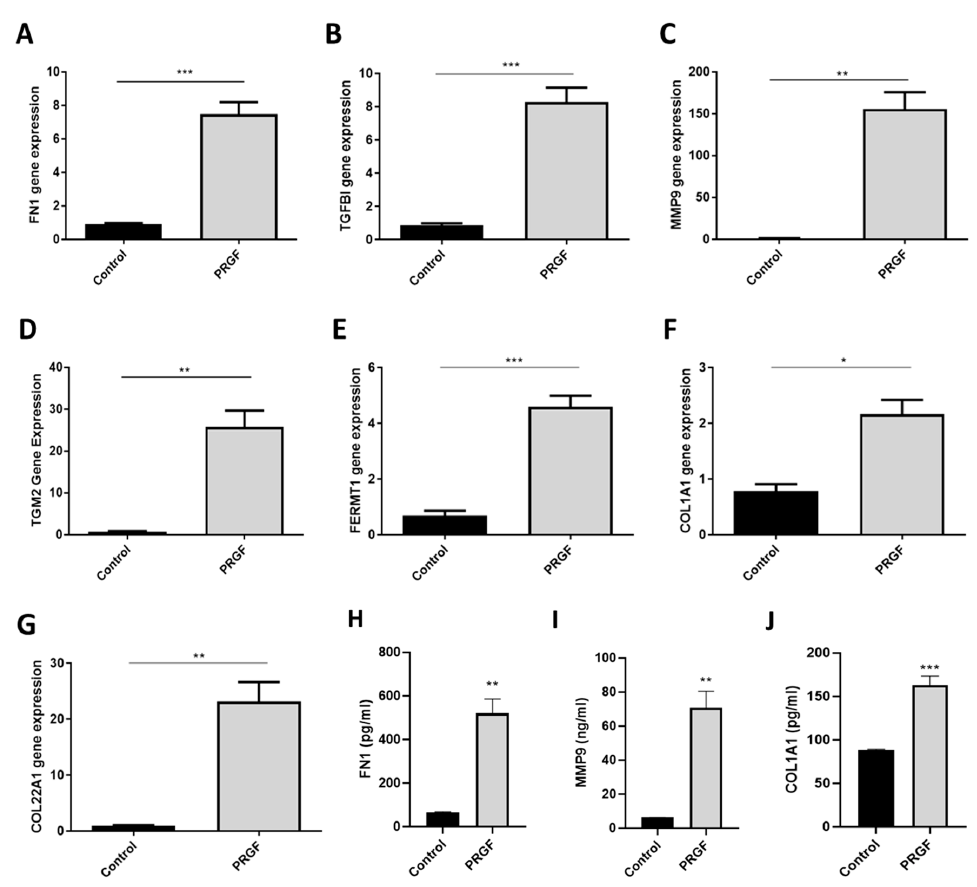
Figure2. PRGFinducesgeneexpressionofvariousextracellularmatrix(ECM)-relatedproteinsinhuman Figure 2. PRGF induces gene expression of various extracellular matrix (ECM)-related proteins in human keratinocytes. Human primary keratinocytes were stimulated for 20 h with PRGF keratinocytes. Human primary keratinocytes were stimulated for 20 h with PRGF preparations derived preparations derived from 10 different donors. Relative gene expression of FN1, TGFBI, MMP9, from 10 di ff erent donors. Relative gene expression of FN1, TGFBI, MMP9, TGM2, FERMT1, COL1A1 TGM2, FERMT1, COL1A1 and COL22A1 was analyzed by real-time polymerase chain reaction (PCR) and COL22A1 was analyzed by real-time polymerase chain reaction (PCR) ( A – G ). Protein release of keratinocytes stimulated for 20 h with PRGF preparations from three di ff erent donors was analyzed by enzyme-linked immunosorbent assay (ELISA) specific for FN1, MMP9 and COL1A1 ( H – J ). Shown are means ± s.e.m (* p < 0.05, ** p < 0.01, *** p < 0.001; Student’s t